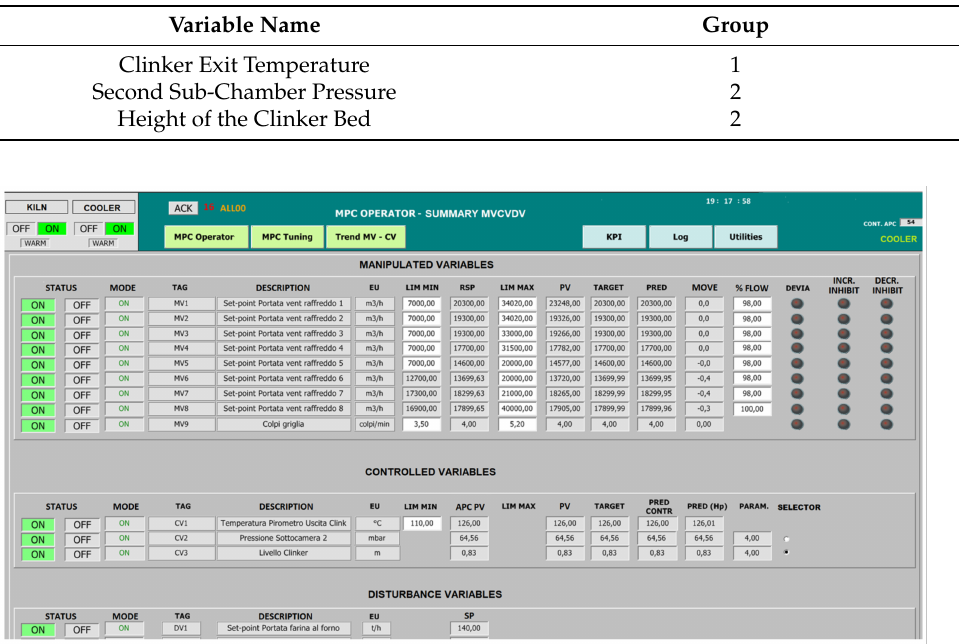
Table 10. Grate cooler APC system: main CVs grouping policy.